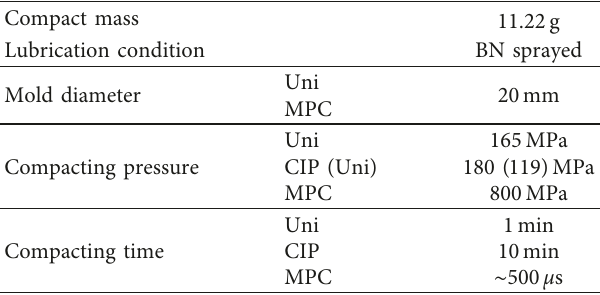
Table 1: Compacting conditions used for uniaxial pressing (Uni), cold isostatic pressing (CIP), and magnetic pulsed compaction (MPC) processes.